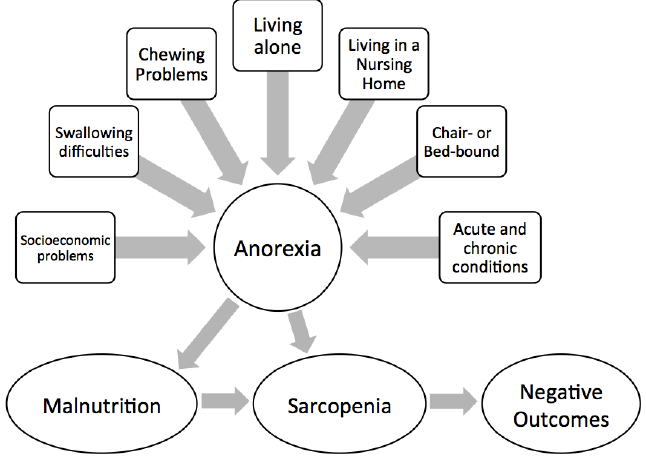
Figure 3. Risk factors for anorexia of aging and negative outcomes.